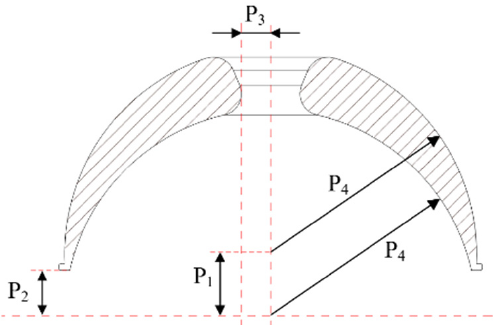
Figure 5. Illustration of structural parameters to be optimized in a bowl-shaped tile. The variation range of structural parameters is shown in Table 1. Table 1. Range of structural parameters to be optimized in a bowl-shaped tile.